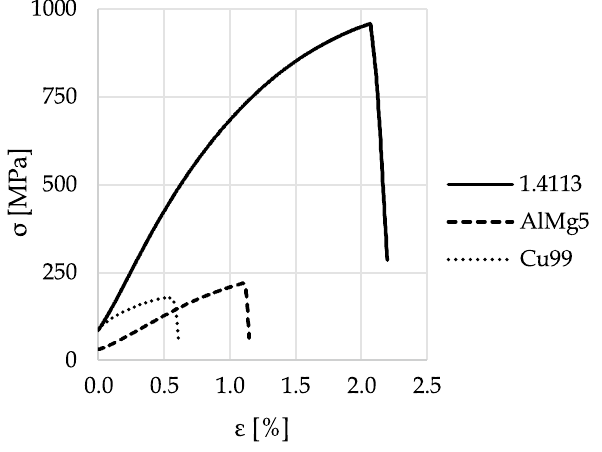
Table 4 Correlation analyses of tensile properties of 1.4113